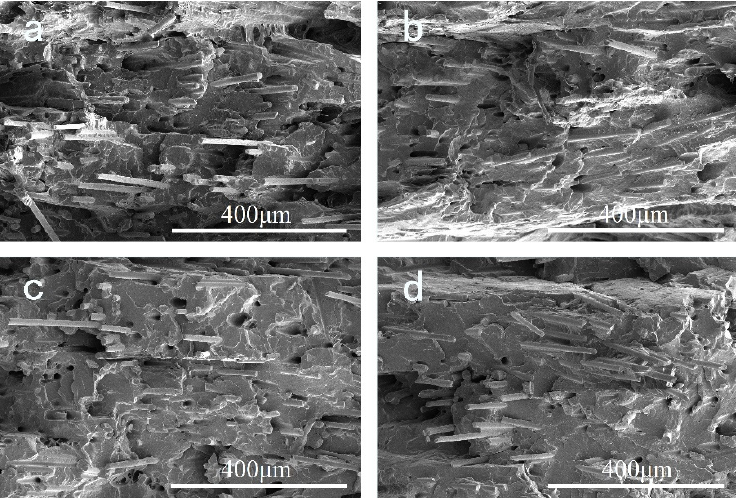
Figure 10. Cross section morphology with high magnification of cryo-fractured samples of ( a ) S-1;